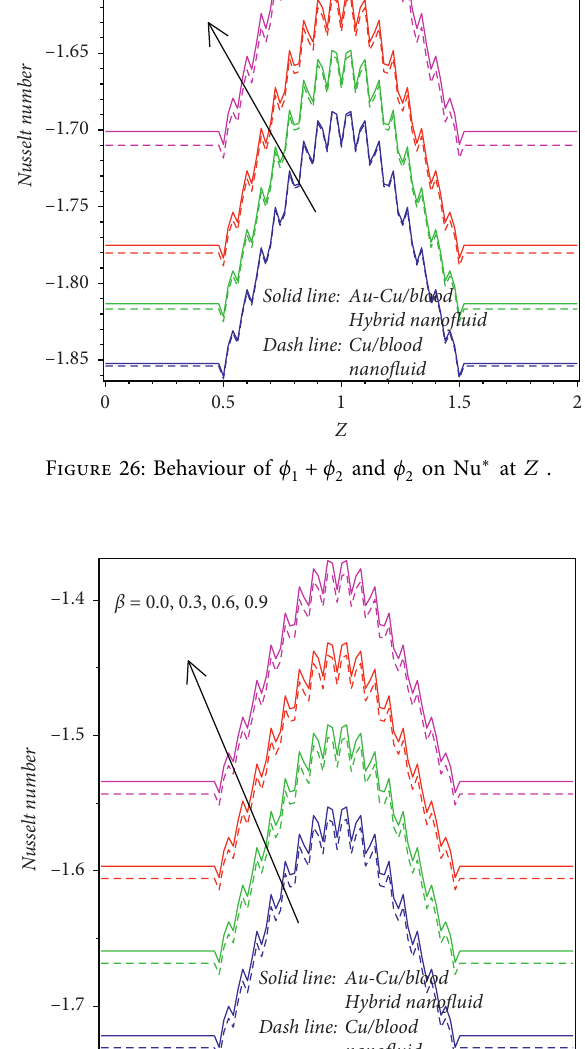
Figure 27: Behaviour of β on Nu ∗ at Z